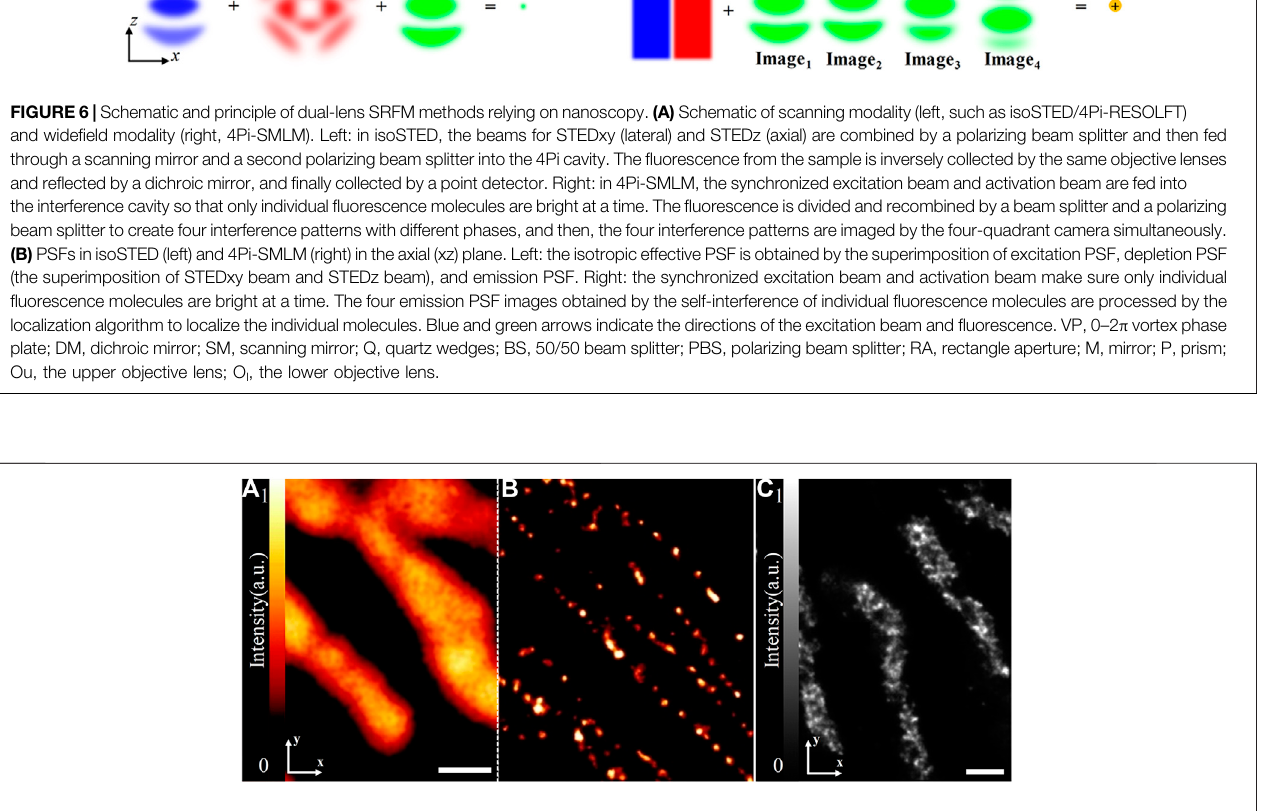
re fl ected light-sheet microscopy (RLSM) [58], in which the vertical light sheet focused by IO on the surface of atomic force microscopy (AFM), cantilever is re fl ected by 90 ° off to produce a horizontal light sheet, and the fl uorescence is detected by a